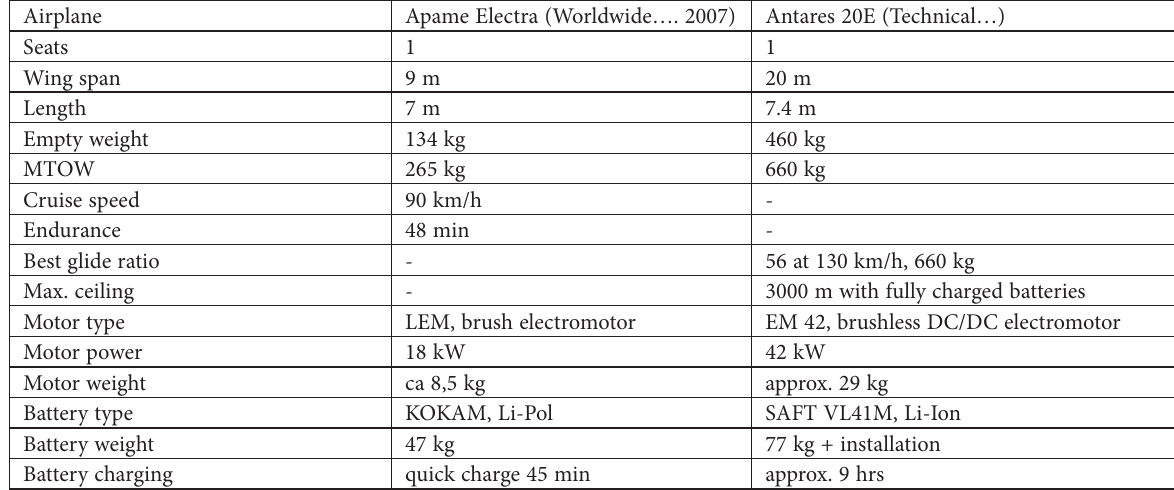
Table 3. Battery-powered airplanes Airplane